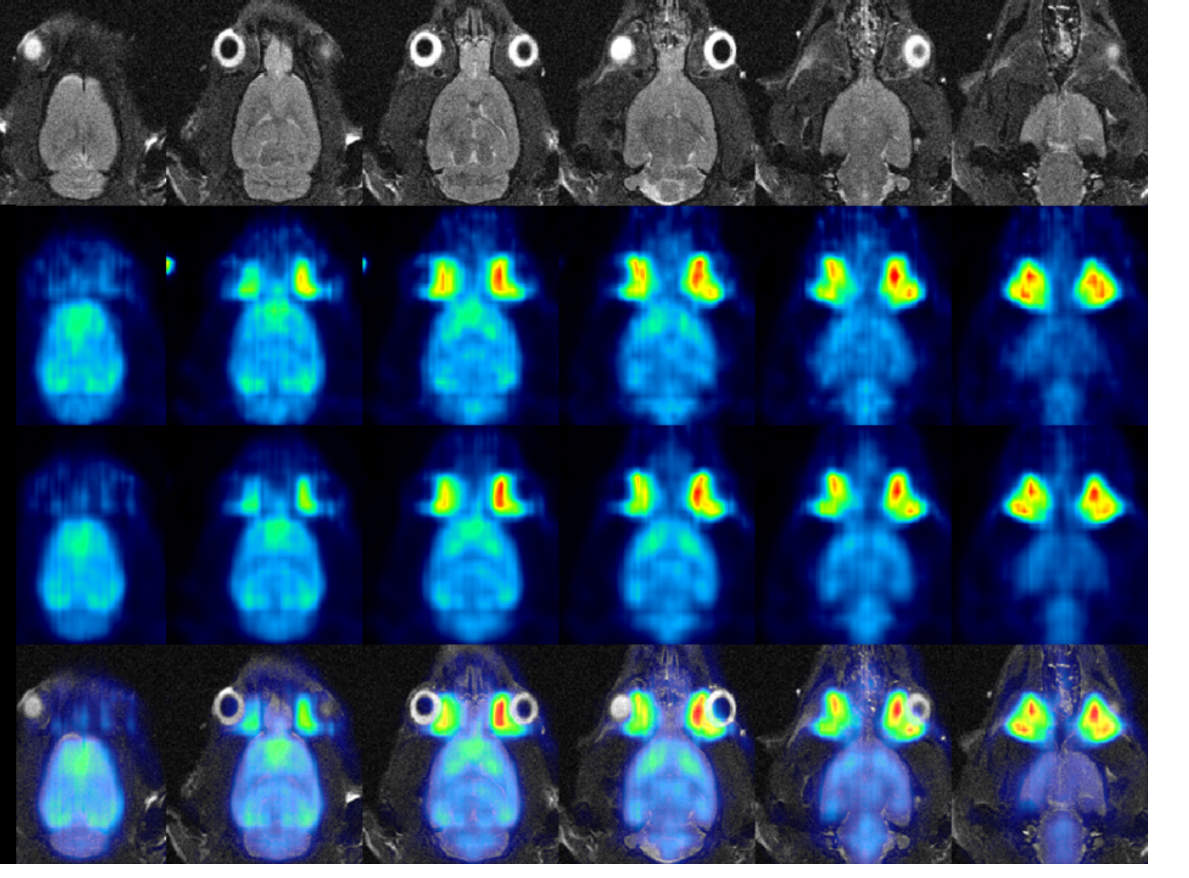
Figure 14. Coronal view of the rat brain in vivo. ( Top row ): MR images acquired with a T2-TurboRARE sequence. ( Second row ): PET data acquired at low dose. Average over frames 22–25, corresponding to 25–45min after tracer injection. ( Third row ): PET data acquired at high dose. Average over frames 22–25, corresponding to 25–45min after tracer injection. ( Bottom row ) Fused MRI and high dose PET